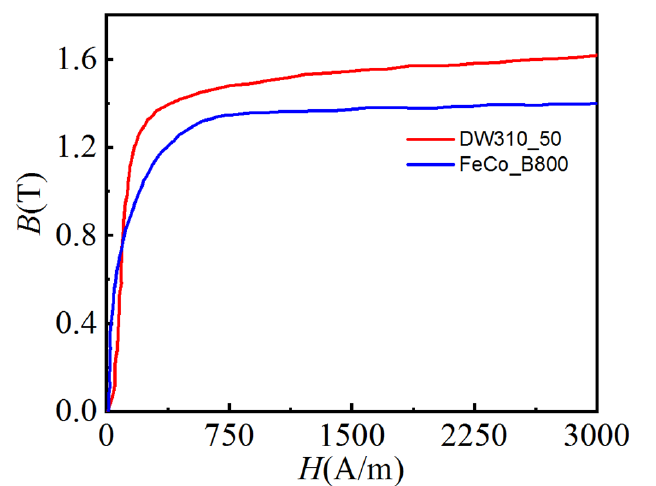
Figure 2. Experimental setup test.